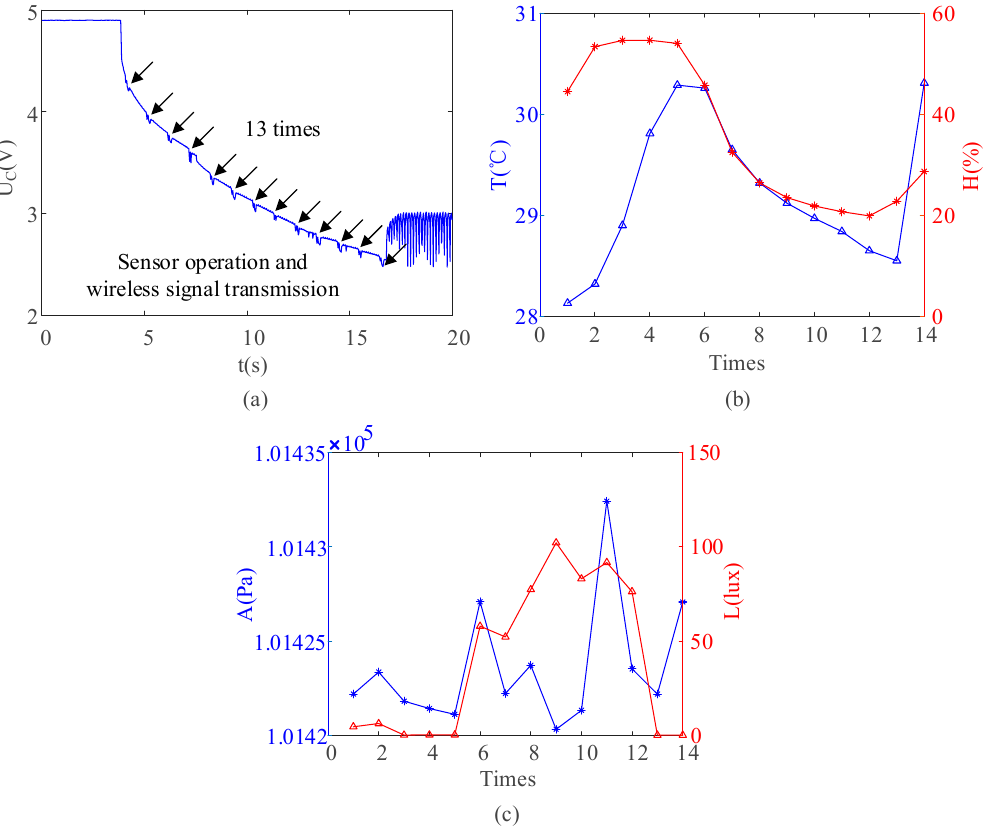
Figure 11. ( a ) Discharging progress with capacitance of 100 mF and ( b , c ) the data of the sensor.